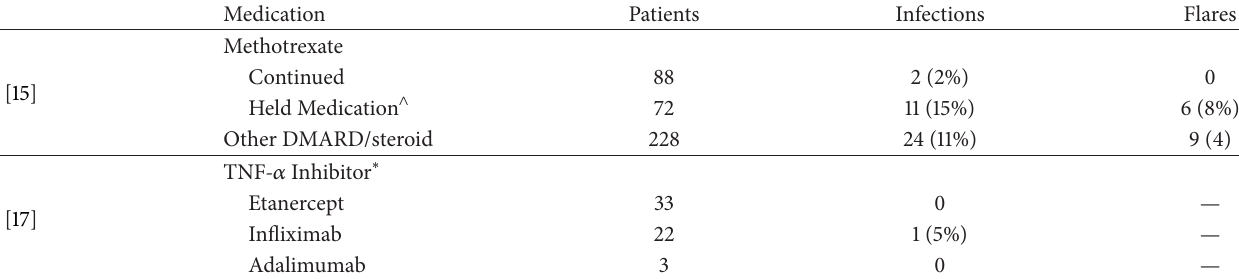
Table 2: Literature review of DMARD safety in the perioperative